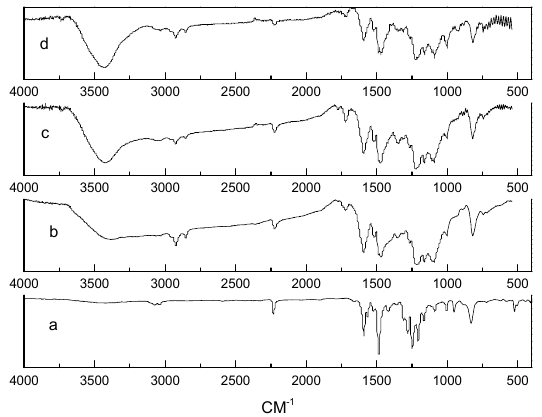
Figure 14. FTIR spectra of: ( a ) pre polymer, ( b ) neat polymer, ( c ) EP0408-0.5 polymer, and ( d ) AM0281-1 polymer.